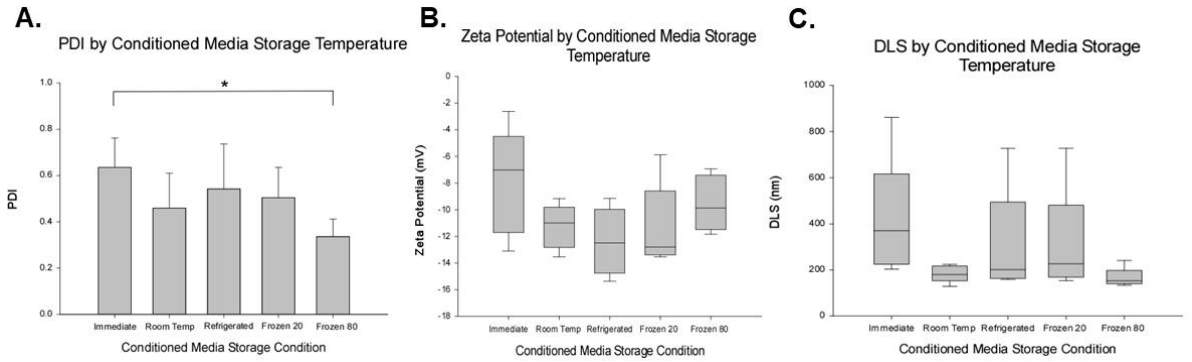
Figure 4. Pre-processing storage condition effects on dynamic light scatters data. The polydispersity index (PDI) in ( A ), the zeta potential in ( B ), and dynamic light scattering (DLS)- based EV size in panel ( C ). Note in ( A ), there was a significant decrease in PDI, indicating that pre-processing storage at -80 °C had a less complex solution in terms of particle size distribution compared to the solution obtained by immediate isolation of EVs. In both ( B ) and ( C ), no significant effects of pre-processing storage condition on zeta potential ( B ) or DLS-based particle size ( C ). However, clear trends were observed in DLS data ( A – C ), suggesting that the immediately processing to isolate EVs was a more diverse and complex solution compared to that obtained after pre-processing storage at -80 °C. In figure A, ANOVA main effect significant, followed by post hoc pre-planned comparisons. In panel A, averages (means) + standard deviation are shown. In panels ( B ) and ( C ), box and whisker plots show median, first, and third quartile in box and 10th and 90th percentile in whiskers. Asterisk depicts significant difference, p -value < 0.05.